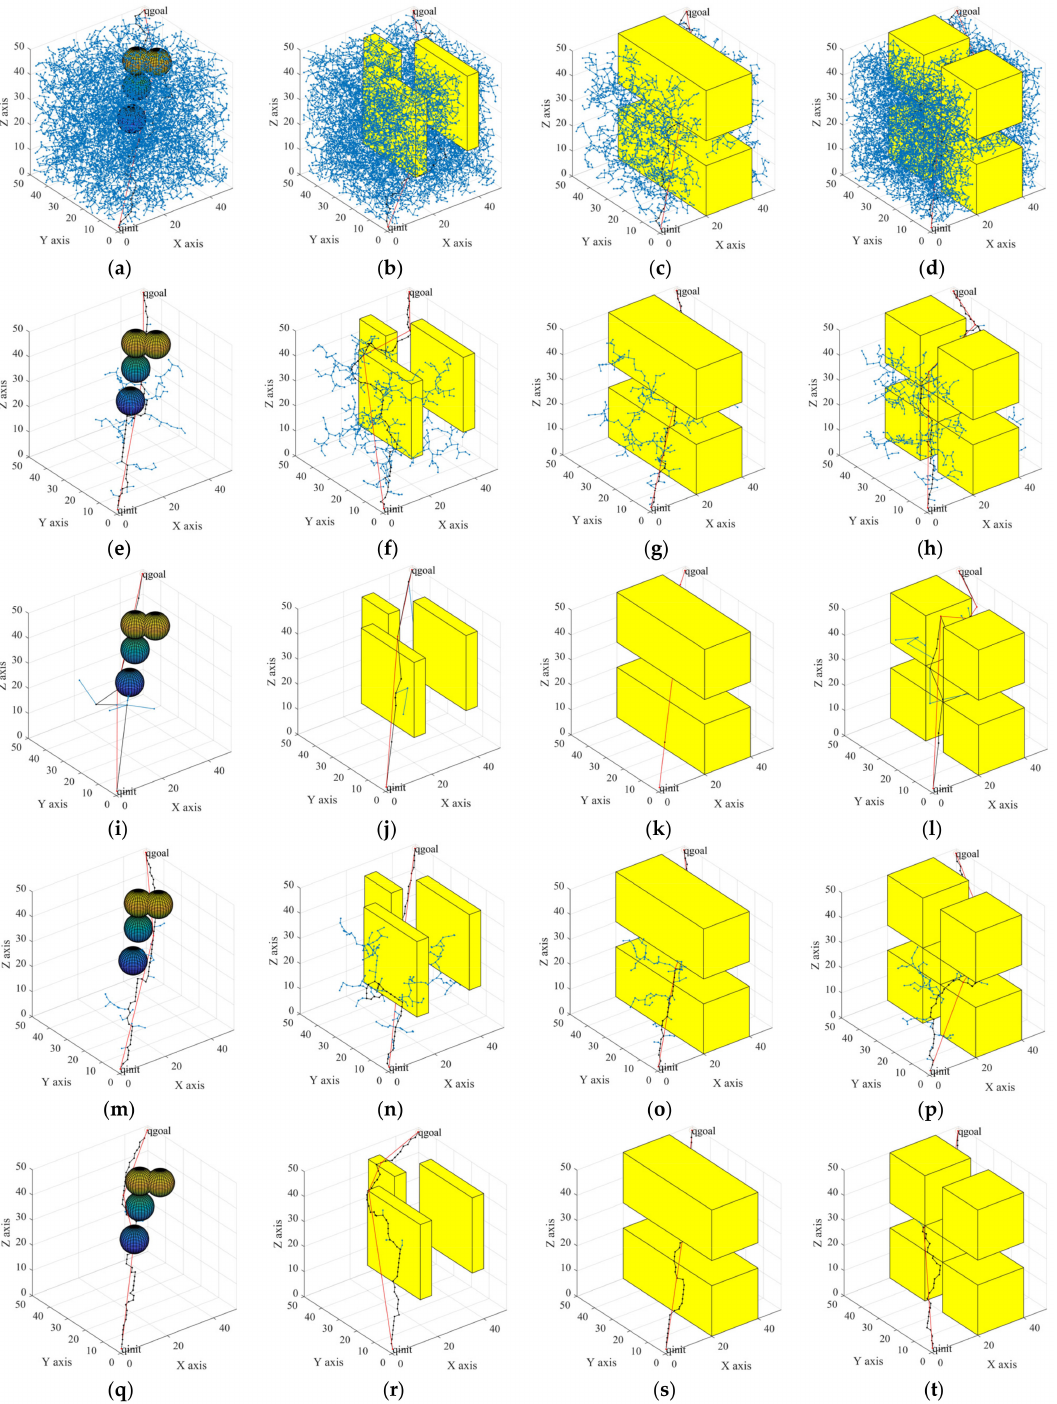
Figure 9. The performances in different environments of: the RRT algorithm ( a – d ); the biased-RRT algorithm with a target offset probability of 50% ( e – h ); the TO-RRT algorithm ( i – l ); the RRT-BCR algorithm ( m – p ); and the NC-RRT algorithm ( q – t